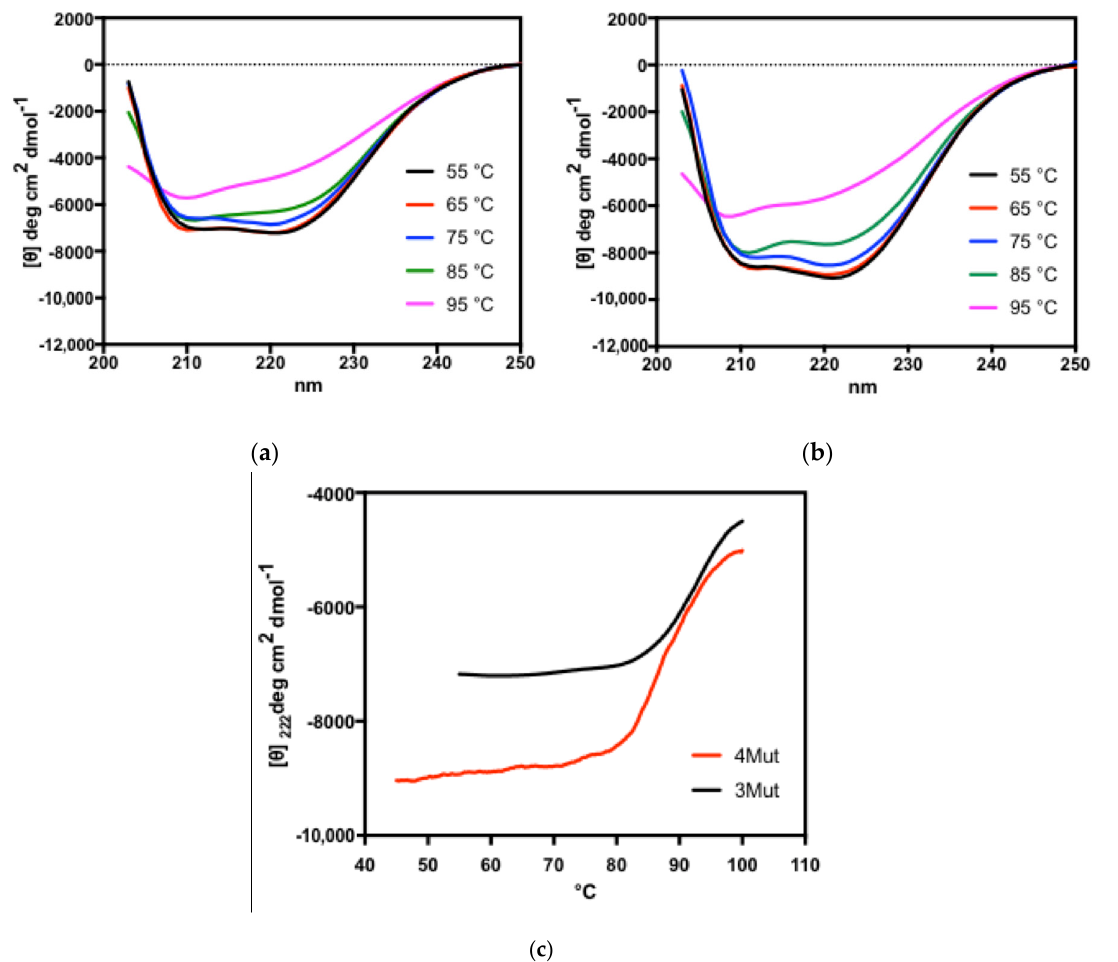
Figure 8. Far-UV CD spectra of ( a ) 3Mut and ( b ) 4Mut. The CD spectra were obtained at 55, 65, 75, 85 and 95 °C. ( c ) Thermal denaturation curves of 3Mut (black line) and 4Mut (red line). Thermal denaturation curves were measured by recording the molar ellipticity at 222 nm, and melting temperatures (Tm) for 4Mut and 3Mut were determined as 86.7 °C and 92.3 °C, respectively.